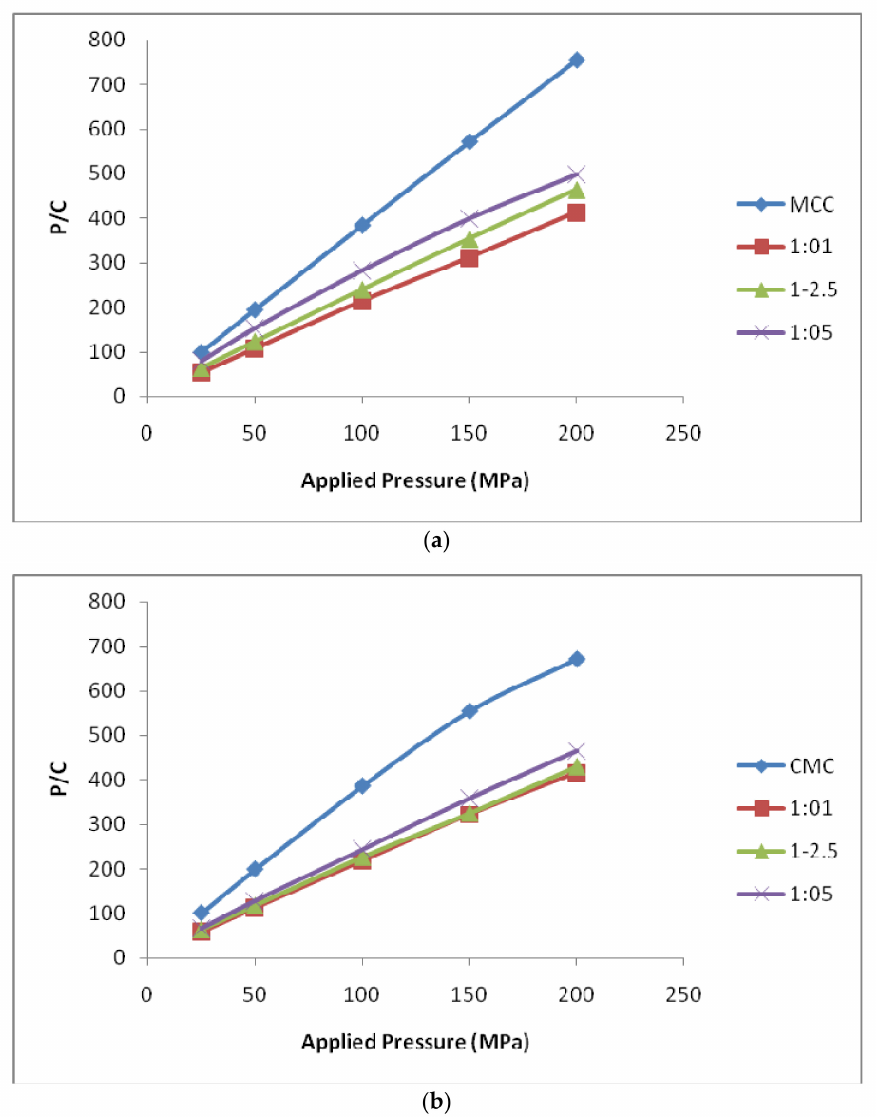
Figure 6. Kawakita- Plots for the tablet incorporating ( a ) MCC-SiO 2 conjugates as a super-disintegrant prepared in ratio 1:1, 1:2.5 and 1:5. ( b ) CMC-SiO 2 conjugates as a superdisintegrant prepared in ratio 1:1, 1:2.5 and